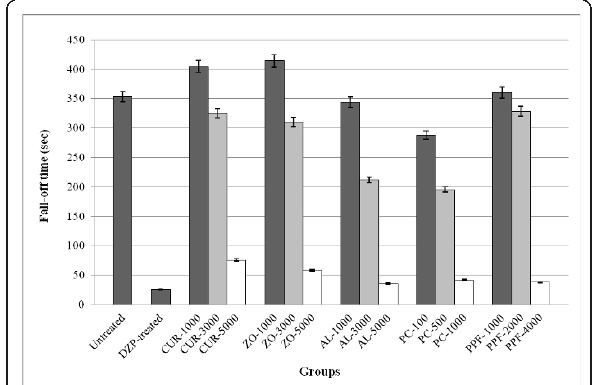
Figure 5 Effect of test materials on locomotive activity (represented by mean ± SEM of fall-off time in seconds) in rats following treatment with the test materials (CUR compound and extracts of ZO, AL, PC, and PPF at various dose levels) in comparison with untreated control and diazepam (reference control) . Statistically significant difference by ANOVA, followed by post hoc scheffe test: CUR-treated group at high dose level vs. control group (p < 0.001). ZO-treated group at high dose level vs. control group (p < 0.001). AL-treated group at high dose level vs. control group (p < 0.001). PC-treated group at high dose vs. control group (p < 0.001) PPF-treated group at high dose vs. control group (p < 0.001). Diazepam-treated group vs. control group (p < 0.001).